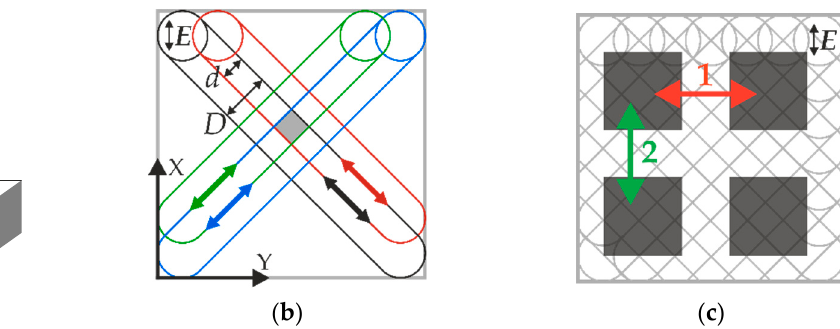
Figure 2. ( a ) Scheme of experimental setup used to process the a-Si films by femtosecond laser pulses. ( b ) Scanning mode template of femtosecond laser irradiation. Four different laser beam passes are indicated by black, red, green, and blue colors. The arrow E indicates laser polarization. ( c ) Scheme of the electrical contacts (gray squares) on the irradiated sample.